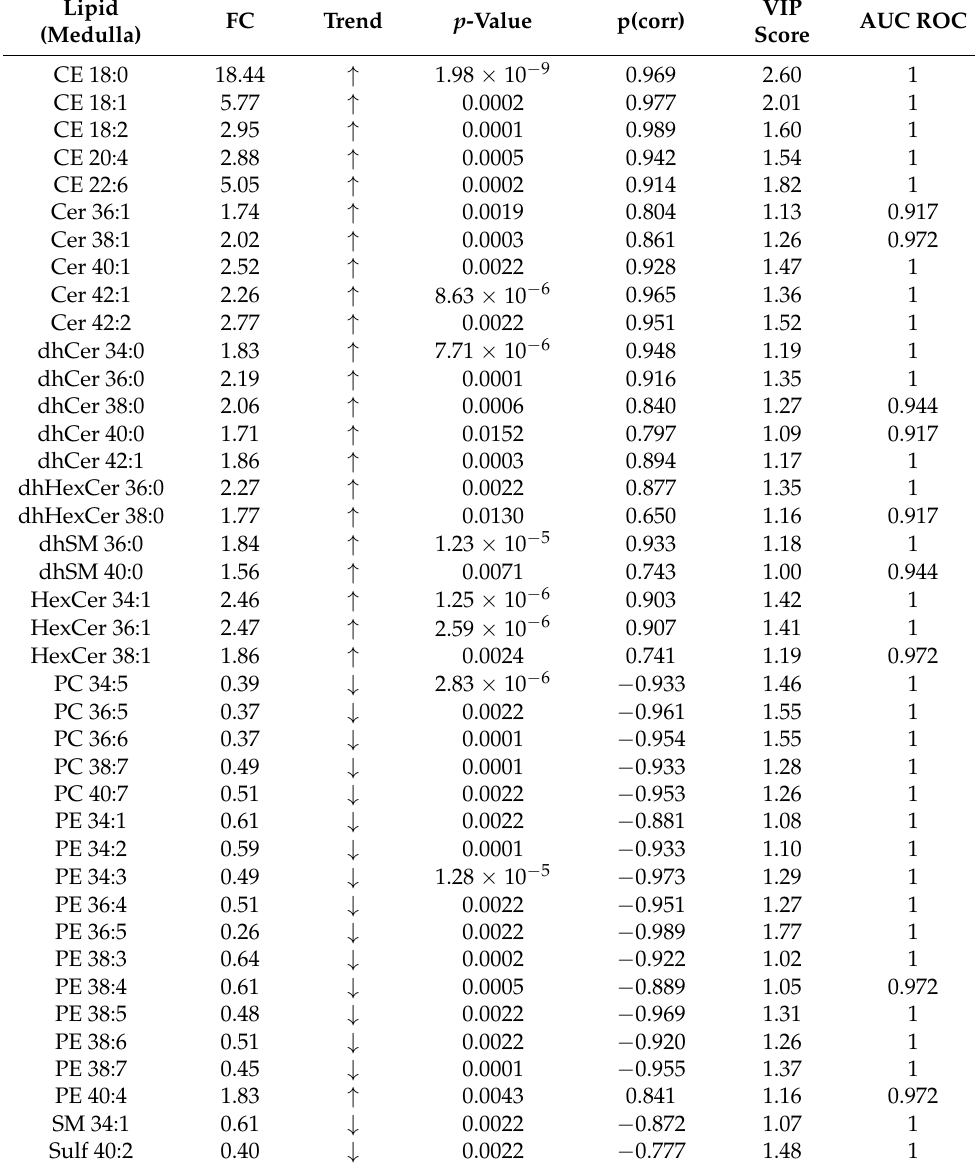
Table 3. Selected medulla lipids, potential biomarkers of cisplatin-induced renal damage. CISPL was compared with CNT. p -values from univariate analysis are considered. FC and AUCs from the ROC are included. Lipids with a p -value < 0.05, FDR < 0.1, |p(corr)| > 0.5, and VIP score > 1 from the OPLS-DA model are